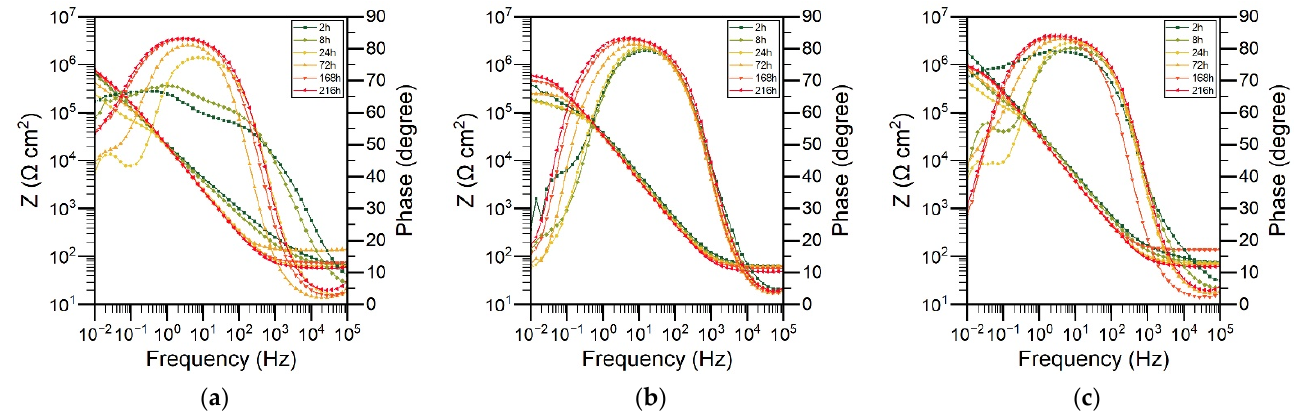
Figure 10. Impedance and phase angle plots of ( a ) C10-1, ( b ) C10-4.5, ( c ) C10-9 after 2, 8, 24, 72, 168, and 216 h of immersion.